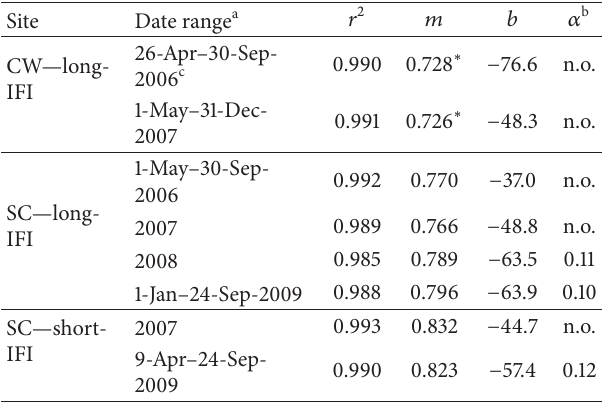
Table3:Leastsquaresregressionmodelcoefficientsbetween30min observations of solar ( 𝑄 𝑠 ) and net radiation ( 𝑄 ∗ ), 𝑄 ∗ = 𝑚𝑄 𝑠 + 𝑏 . Slopes ( 𝑚 ) marked by an asterisk are not significantly different ( 𝑝 < 0.05